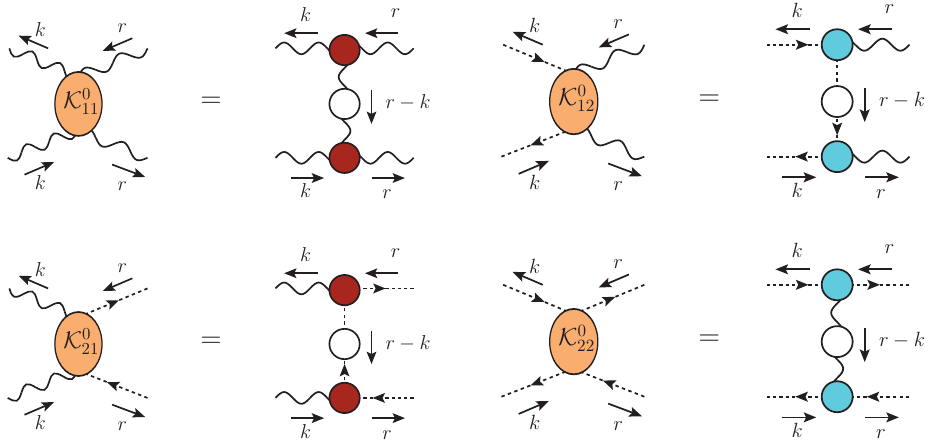
0 , of the kernels appearing in Figure 4. ij K K ij ( r ) C